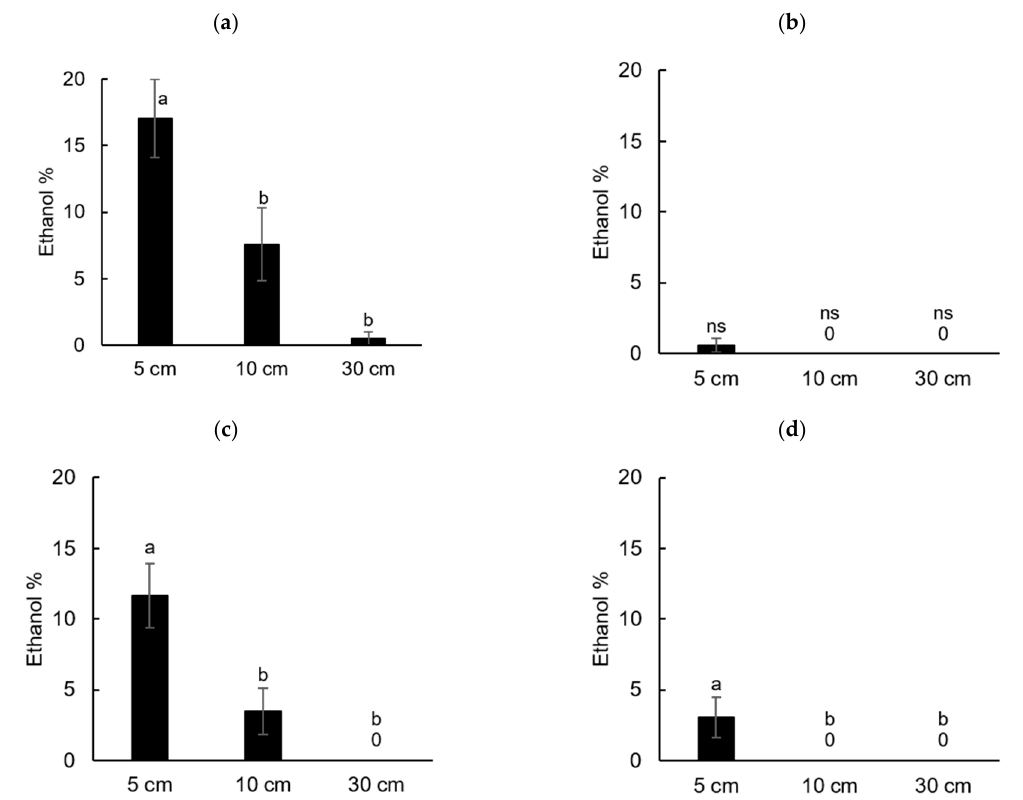
Figure 5. Soil water repellency (SWR) intensity at different soil depths in Ch. obtusa intact tree ( a ), Cr. japonica intact tree ( b ), Ch. obtusa cut tree ( c ) and Cr. japonica cut tree ( d ) plots. Small letters and ns denote significant and non-significant differences, respectively, between different soil depths.